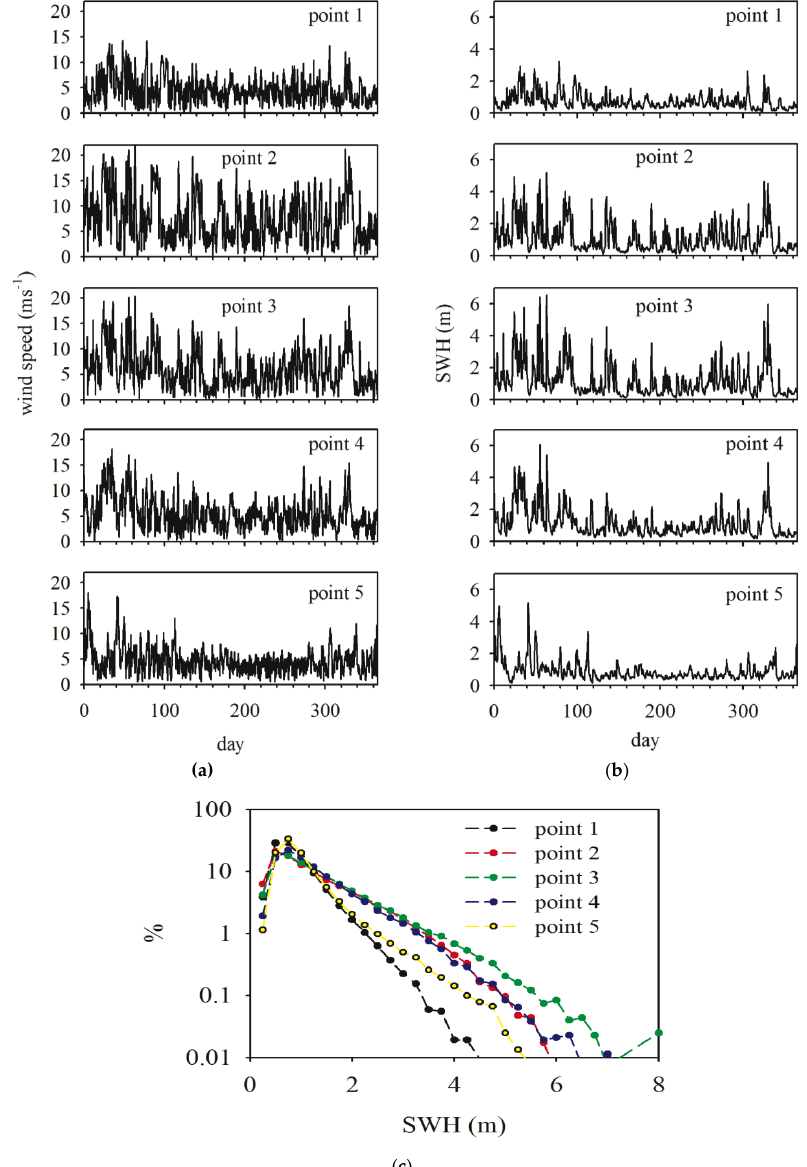
Figure 9. Example time series from year 2015 of: ( a ) wind speed; ( b ) significant wave height (SWH). ( c ) Frequency distribution of SWH in 5 locations based on the entire 36-years’ time series. Data are presented for 5 locations indicated in Figure 4a.